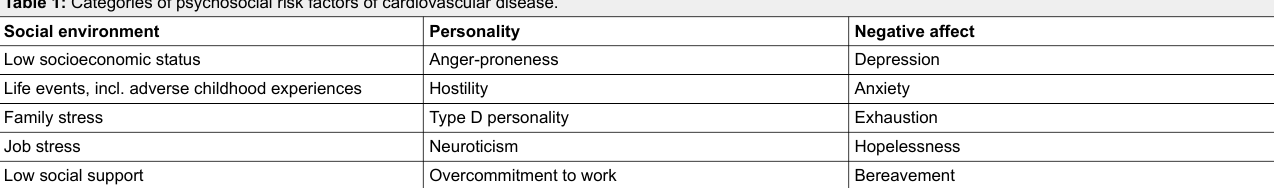
Table 1: Categories of psychosocial risk factors of cardiovascular disease. Social